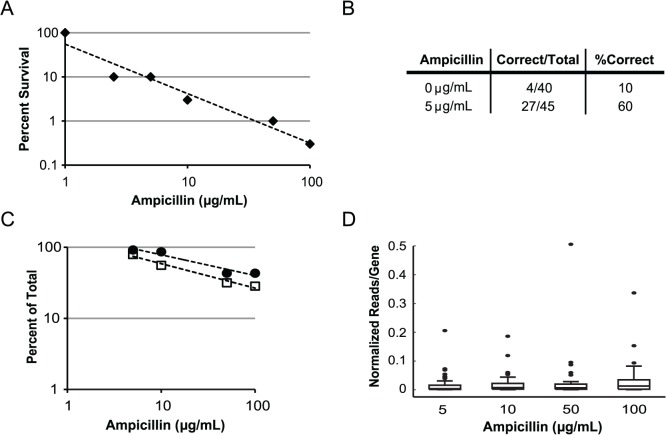
Multiplex Library Synthesis and Expression Correction (MuLSEC) Characterization for a Library of Enzymes.(A) Survival of clones after multiplex library gene synthesis is presented on the y-axis versus the solid media ampicillin concentration on the x-axis. Fewer clones survive on increasing ampicillin concentrations. (log-log plot). (B) Table of Sanger sequencing results on individual clones. Selection on ampicillin at 5 μg/mL led to a 6x increase in the number of perfect clones. (C) Percent of the 95 genes synthesized detected by next generation sequencing after selection on varying concentrations of ampicillin. Data is presented with a cutoff such that the median number of reads per gene must be ≥ 0.05% of total reads per ampicillin concentration condition (open squares) or with no cutoff (closed circles). Fewer genes are detected with increasing ampicillin concentration (log-log plot). (D) Box-and-whisker plot of pool normalized representation of each gene (reads ≥ 0.05% of group total) for increasing ampicillin concentrations. Black dots represent outliers in the dataset.